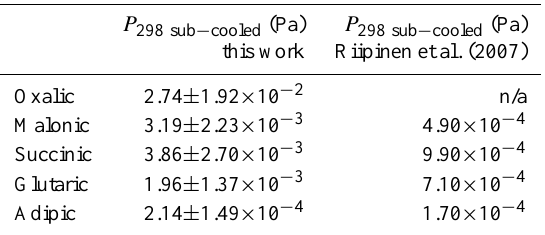
Table 5. Comparison of dicarboxylic acid sub-cooled liquid vapour